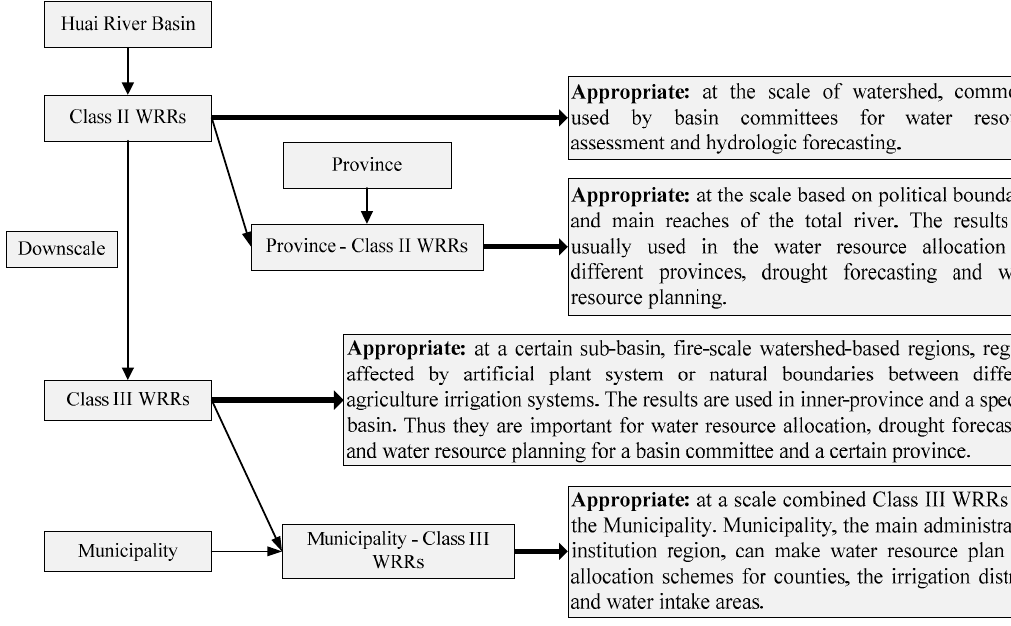
Figure 9. The scale relationship for the employment of water resource vulnerability in the Huai River Basin. The ( ) sign represents the appropriate employed situations for certain vulnerability results on a scale. The ( ) sign represents the downscale arrows.